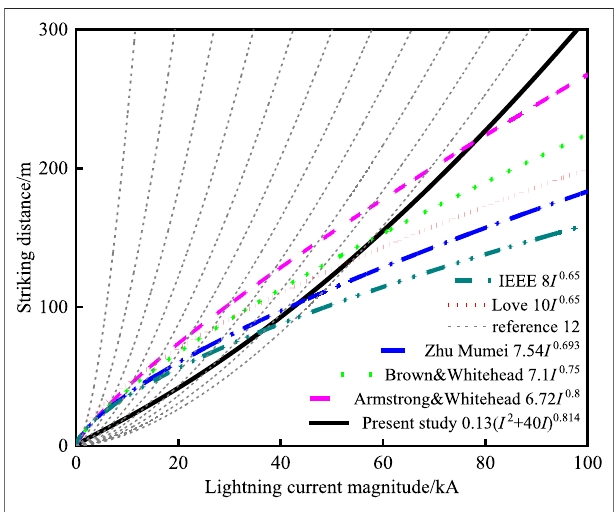
FIGURE 1 | Comparison of different striking distance